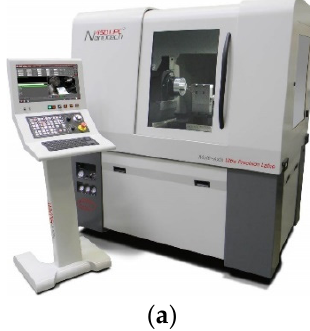
Figure 15. High precision machine tools. ( a ) Nanotech 450UPL. ( b ) Nanoform X [100,101].